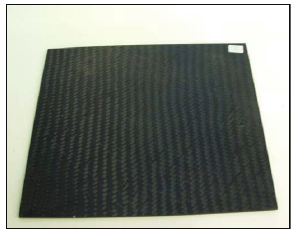
Figure 3: 12K carbon-braided/polyester